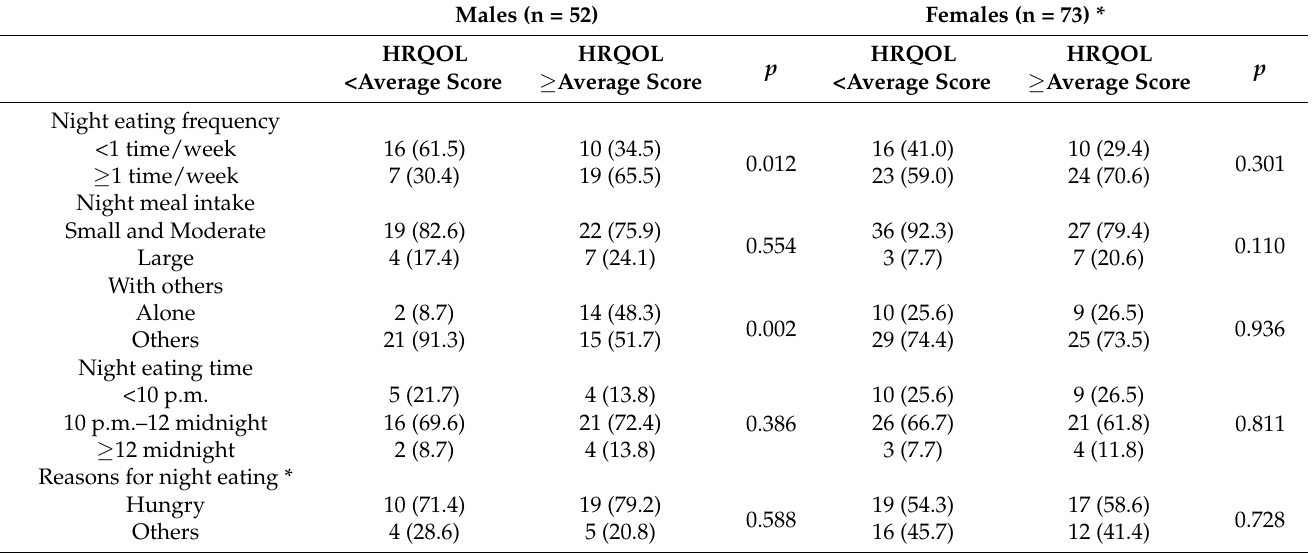
Table 3. Distribution of night eating habits and HRQoL group by